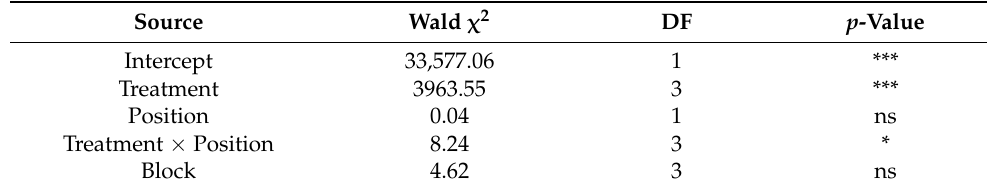
Table A3. Results of repeated-measures analysis with generalized linear model testing the effects of the independent variables block, treatments, positions, and their interaction on floor canopy height.